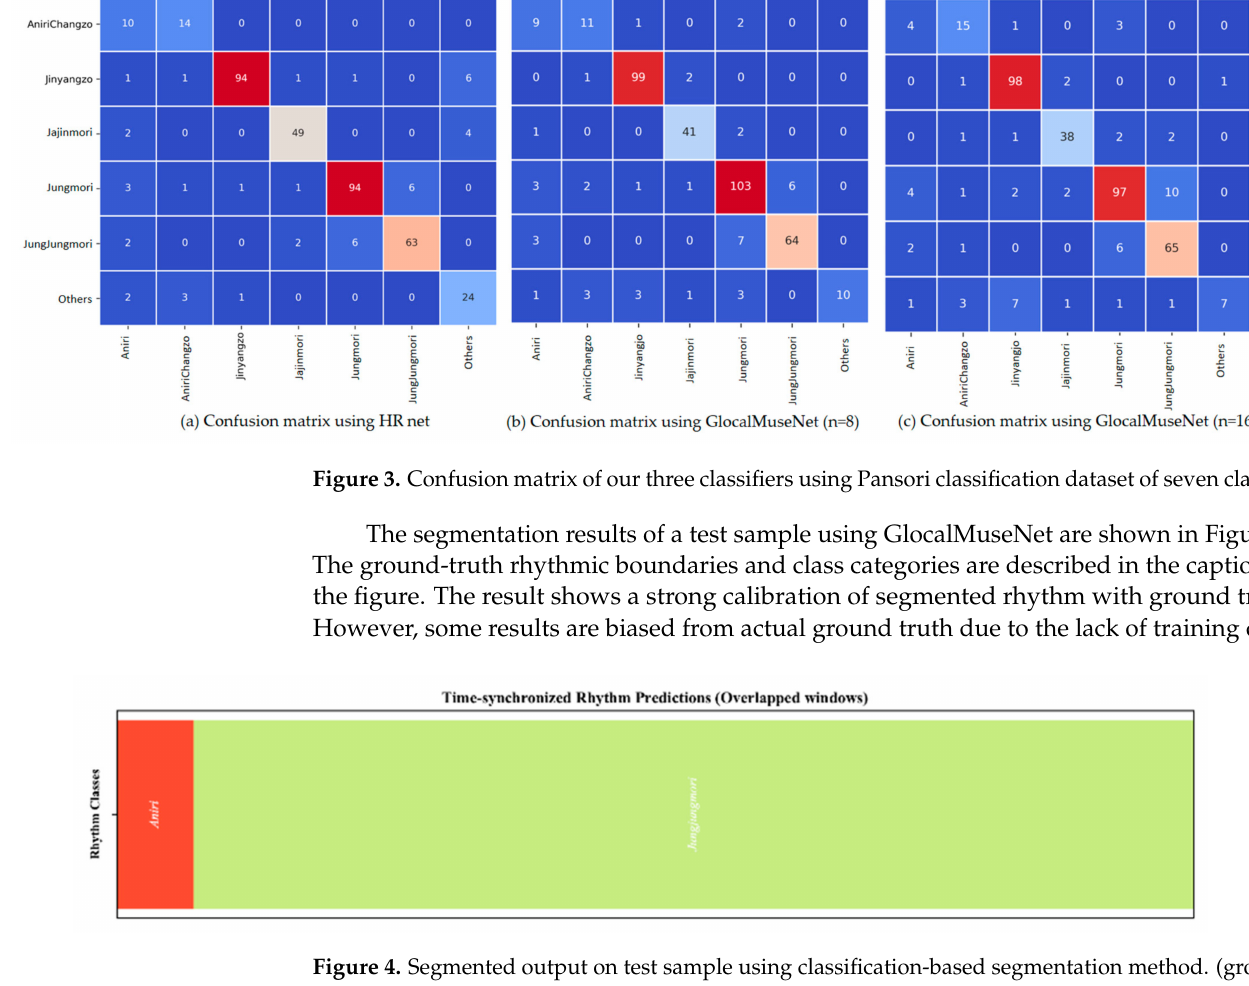
Figure 4. Segmented output on test sample using classification-based segmentation method. (ground truth: Aniri 0 to 17 s and Jungjungmori 18 to 93 s).